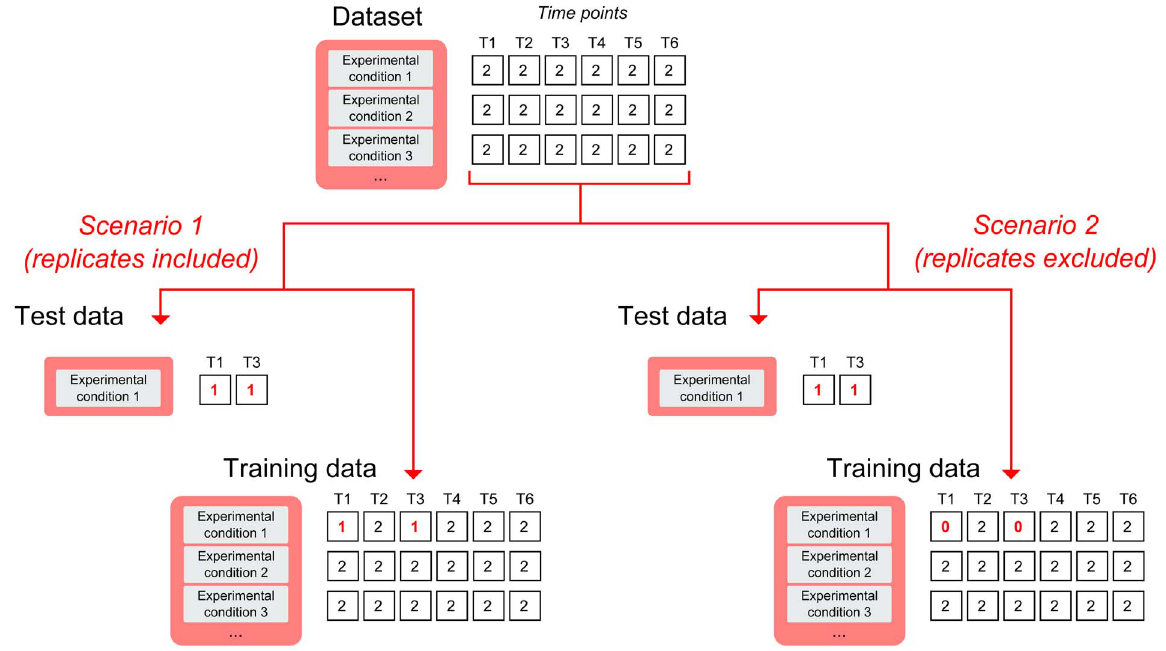
Figure 2. Framework for the evaluation of the performance for methods classifying time-course expression data. In this example, T1 to T6 represent time points. Numbers inside the boxes indicate the number of replicates for each experimental condition at each time point. Test data consists of two time points, T1 and T3, and is taken from the experimental condition 1. In scenario 1, the replicates of the test data are part of the training data, while in scenario 2, the replicates of the test data have been excluded from the training data.